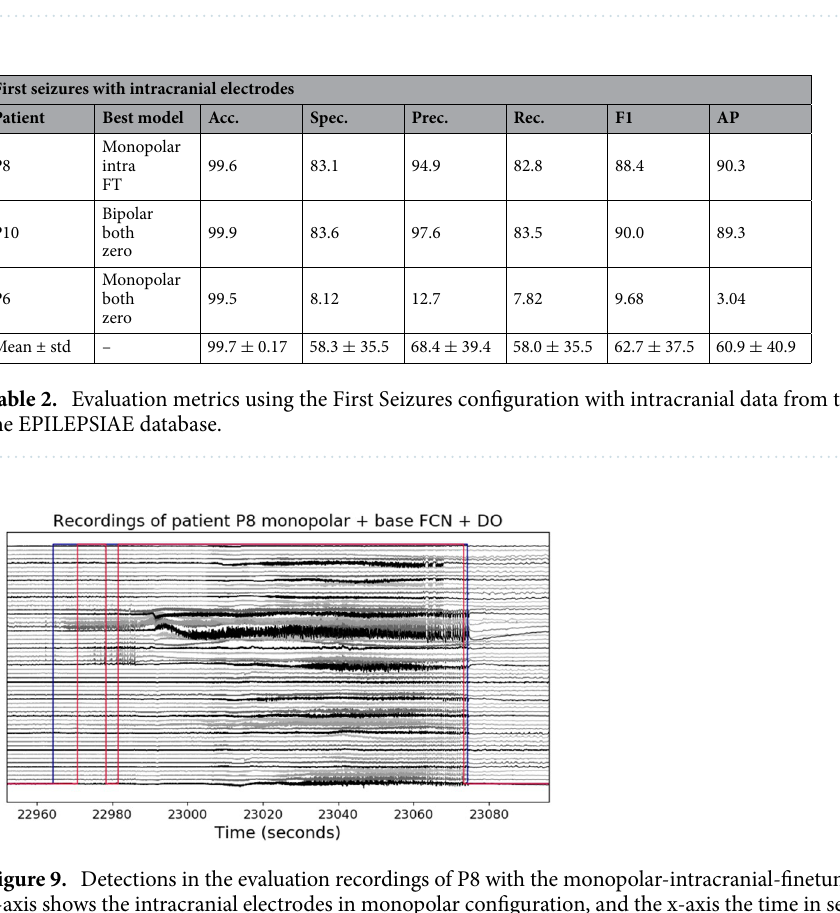
Figure 8. Signal representation of intracranial electrodes in monopolar configuration (57 intracranial contacts for P10). The y-axis corresponds to the intracranial channels labeled as iE N and the x-axis to the temporal dimension. Top and bottom rows present examples of ictal and interictal periods, respectively.